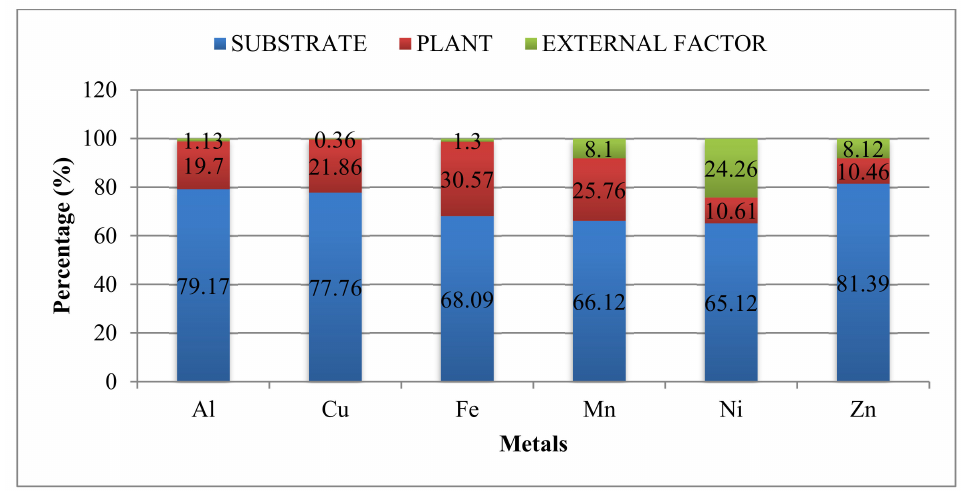
Figure 7. Removal efficiency of metals partitioned between Vetiver, substrate, and external